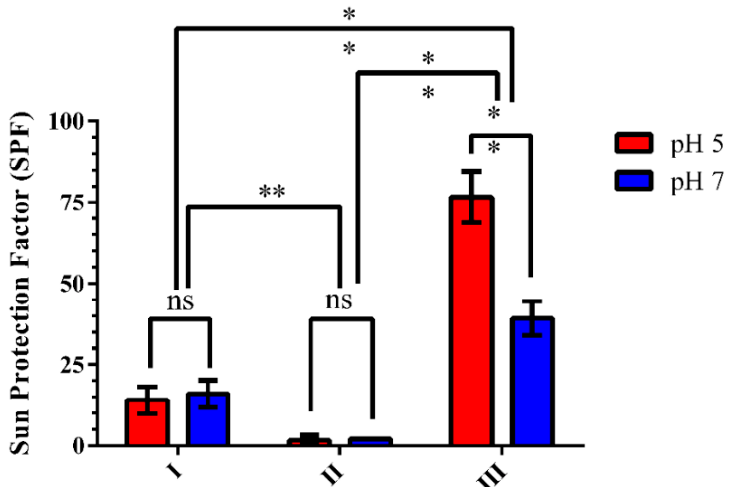
Figure 4. In vitro sun protection factor of formulations I, II and III containing grape pomace extract at two pH values 5 and 7 ( n = 3). pH ( p < 0.001), concentration ( p < 0.001) and interaction ( p < 0.001). Post hoc Sidak test. Formulation I—base and UV filters; II—base and grape pomace; III—base, UV filters and grape pomace. ** = significant ( p < 0.001), * = significant ( p < 0.01) and ns = not significant.